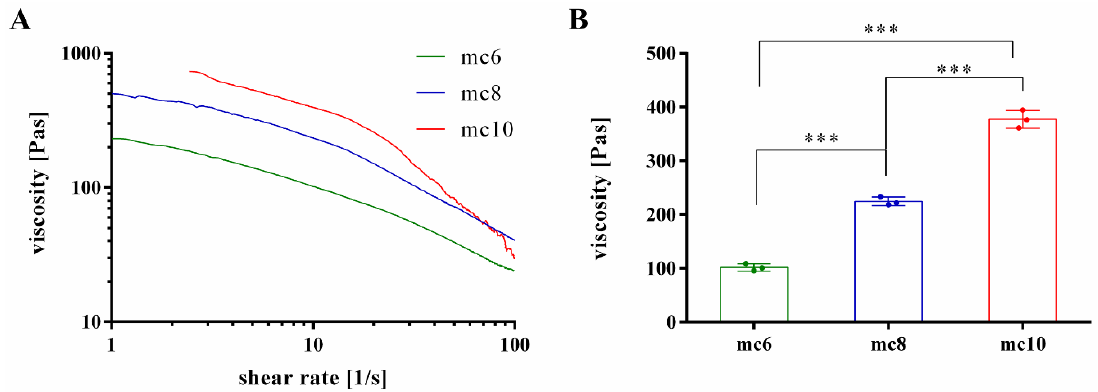
Figure 1. Rheological investigations on shear thinning behavior of mc6, mc8, and mc10 support bioinks. ( A ) Representative viscosity measurements at increasing shear rates; ( B ) Viscosity at a shear rate of 10 s −1 (mean ± SD, *** p < 0.001, n = 3).